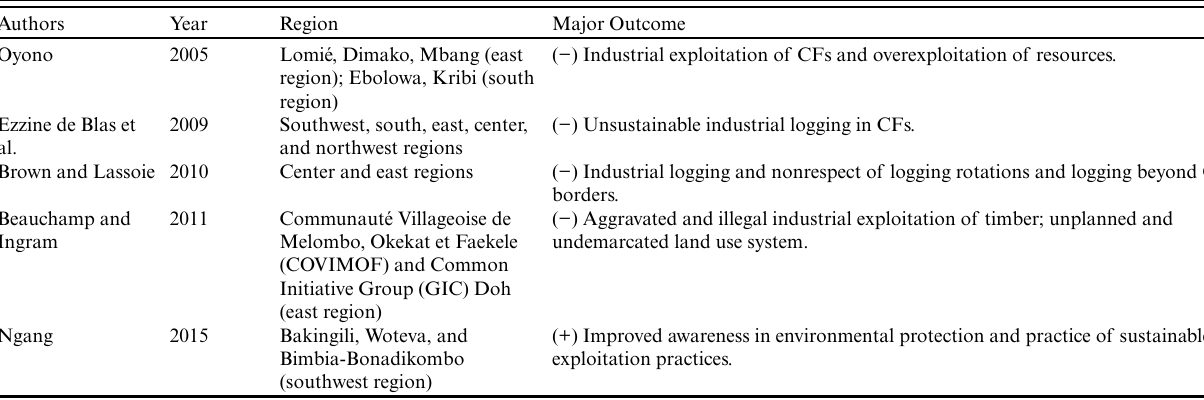
Table 6 . Community forest (CF) direction and vision in CF management in Cameroon. Authors Region Major Outcome